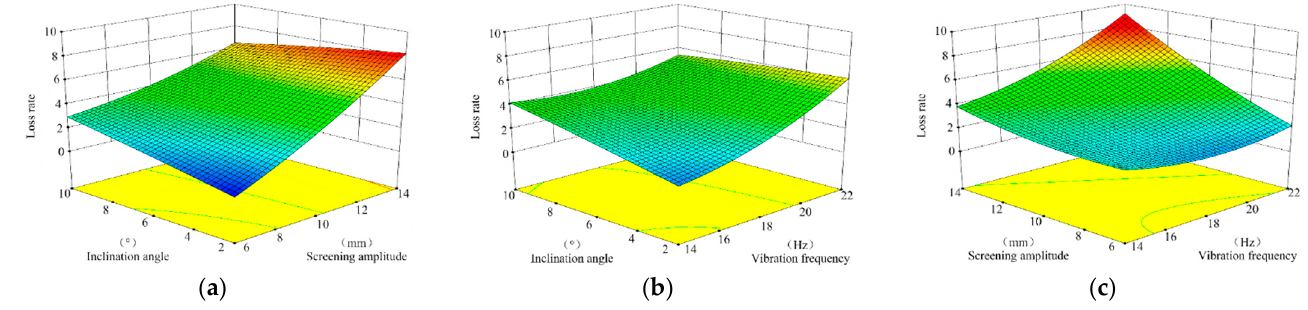
Figure 11. The response surface for the effect of the interaction of the factors on the loss rate. ( a ) Response surface of the effect of SA and IA on screening efficiency; ( b ) Response surface of the ef- fect of VF and IA on screening efficiency; ( c ) Response surface of the effect of VF and SA on screening efficiency.